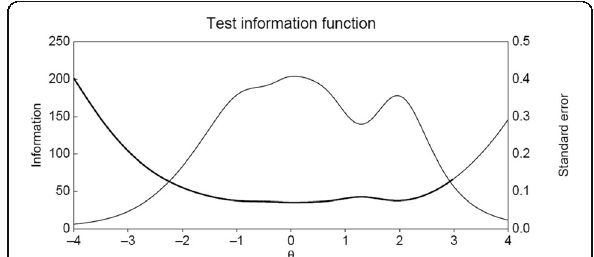
Fig. 2 Test information function of the item bank